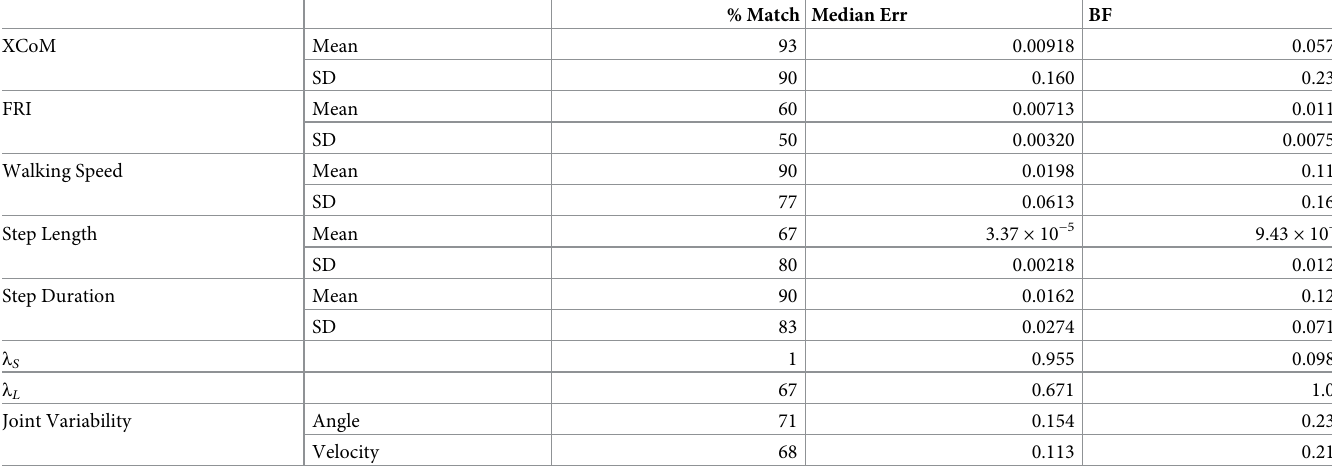
For the short-term Lyapunov exponents, only 1% of the values matched between the Mar- kov chain and brute force methods. The error was also very large, with almost 50% of the dif- ferences greater than 1 in normalized units despite the typical brute force standard deviation being less than 0.1. The large differences were also present in the raw values. This is most likely due to the discretization needed to create the Markov chain because it causes a small range of actual step trajectories to map to the same transition in the Markov chain and can cause a small discontinuity between the end of one step and beginning of the next step. These disconti- nuities may cause errors when measuring differences in the joint trajectories over the duration of two steps. While it may be possible to refine the Markov chain by reducing the discretization threshold distance used to create it, this is computationally expensive and would eventually become intractable. The long-term Lyapunov exponents calculated with the Markov chain seem to be much more accurate than the short-term Lyapunov exponents. This is expected if the issue with short-term Lyapunov exponents was due to the discretization of the Markov chain. Because the long-term Lyapunov exponents evaluate how neighboring trajectories behave over the duration of 4 to 10 strides, any discontinuities between the individual steps become much less significant than the perturbations in the gait. Table 3. Comparison of fall risk metrics between the Markov chain and brute force methods. The % Match column gives the percentage of Markov chain values that were within one standard deviation of the corresponding brute force values. The median error column give the median of the absolute difference between methods. The BF SD column gives the median of the standard deviations from the brute force method. Most metrics matched between the two methods most of the time, with the nota- ble exception of the short-term Lyapunov